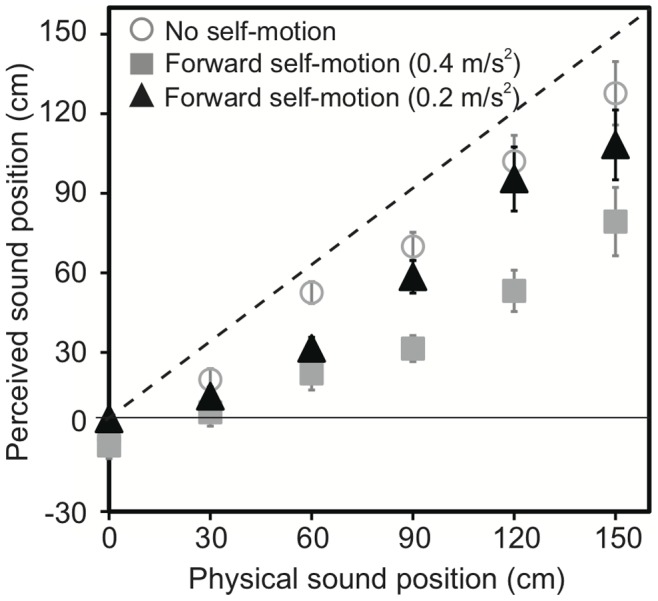
Effect of acceleration on auditory egocentric localization observed in the follow-up experiment included in Experiment 3 (N = 8).The participants were transported forward at 0.2 m/s2 of acceleration while the velocity of the chair was identical with that of the main experiment of Experiment 3 (0.9 m/s). The black triangles represent forward self-motion at 0.2 m/s2 of acceleration, whereas the gray squares and open circles represent the results of the main experiment of Experiment 3 (forward self-motion at 0.2 m/s2 and no self-motion conditions, respectively). The dashed line indicates the ideal performance. Error bars denote standard errors.